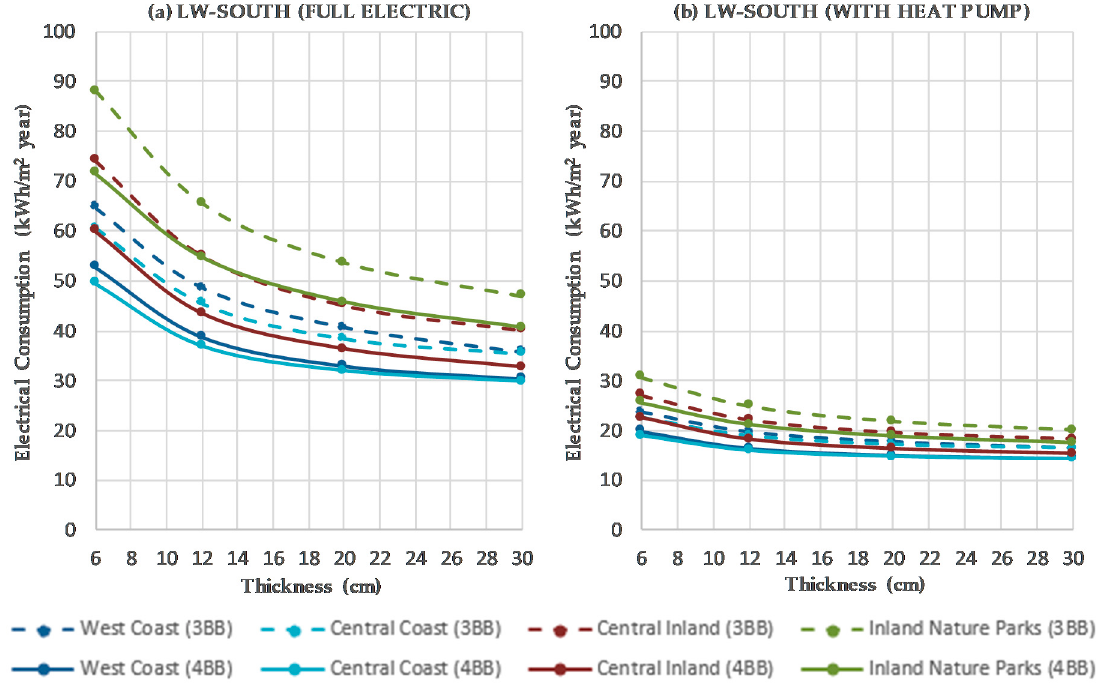
Figure 5. Electrical consumption according the insulation thickness for the four locations with LW-SOUTH for 4BB and for 3BB: ( a ) Electricity only; ( b ) Heat pump plus electricity.